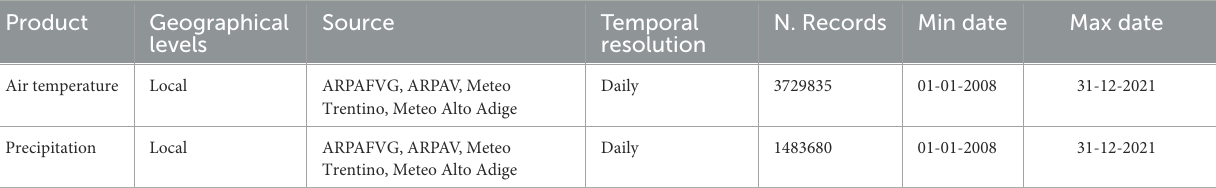
TABLE 2 List of information acquired by ground station as of August 2022.